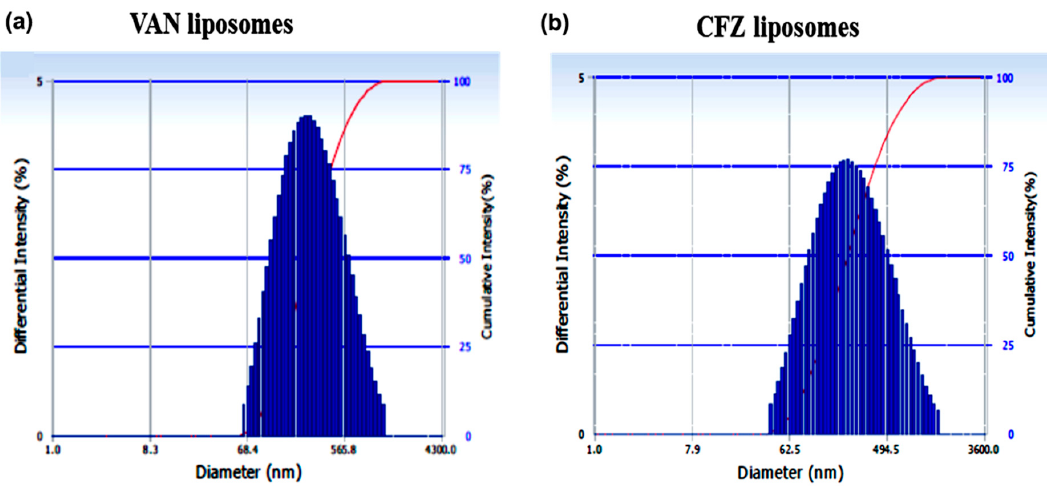
Figure 4. Histograms of vesicle size of ( a ) VAN liposomes and ( b ) CFZ liposomes after six months of shelf-storage. of